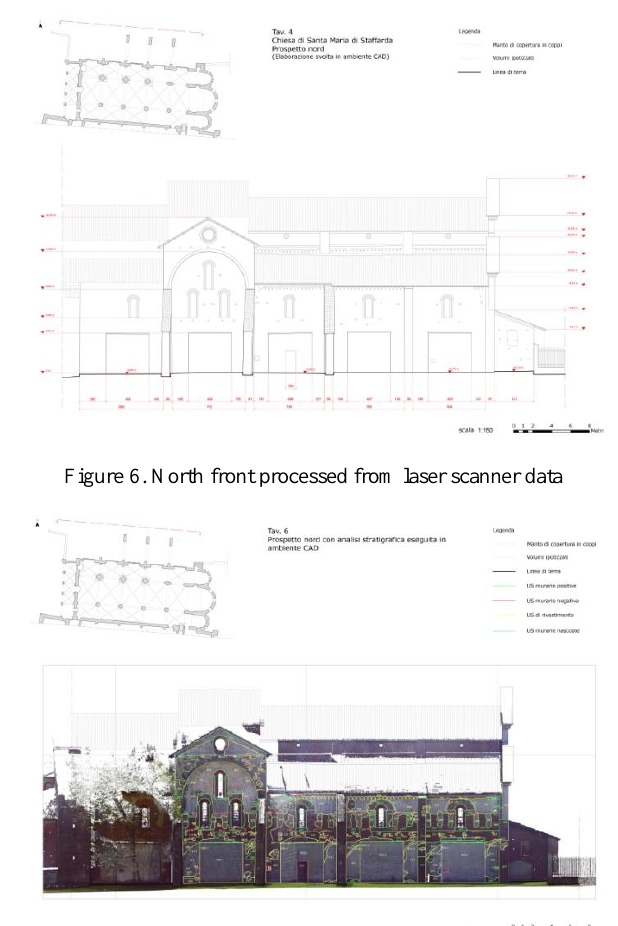
Figure 7.. Stratigraphic analysis of the north facade processed on image extracted from point cloud